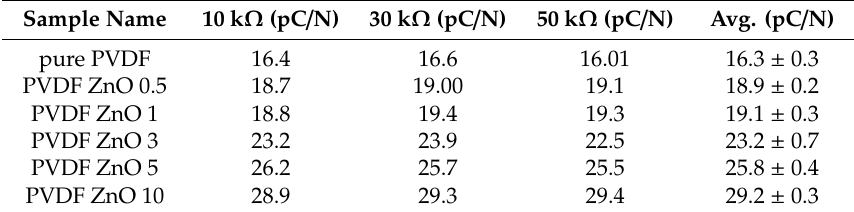
Table 4. Summarized values of d 33 identification.